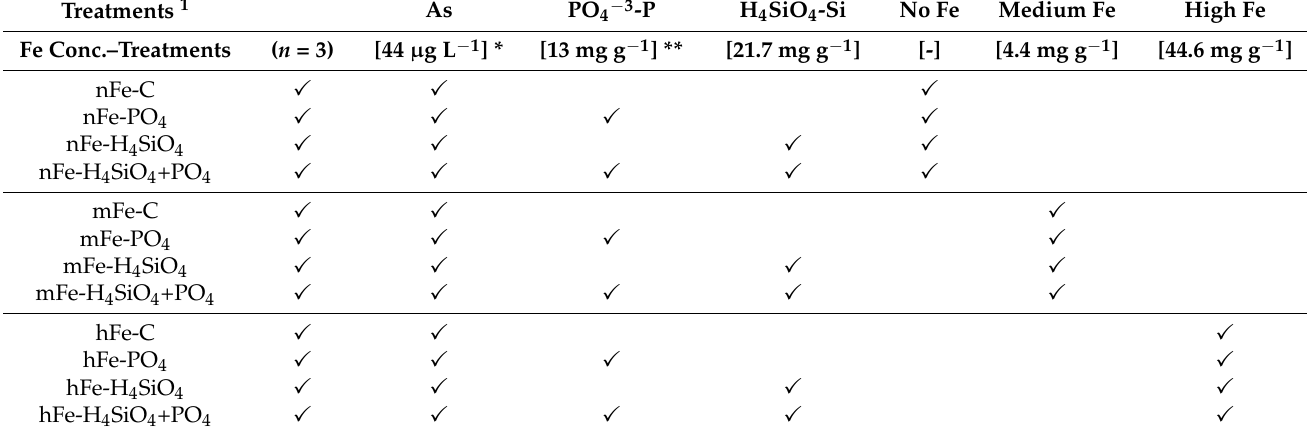
Table 2. The preparation of incubations and descriptions of labeling, solutes, and solid iron oxide added to the respective treatments.